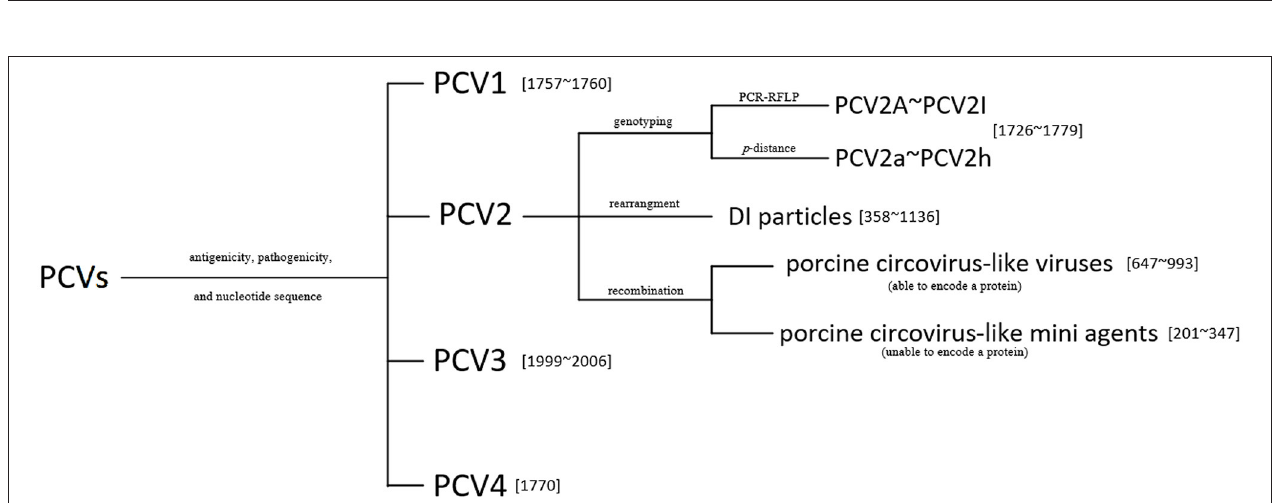
FIGURE 3 | The classification of known porcine circoviruses (PCVs). The genotyping of PCV2 (A–I) using the PCR-RFLP proposed in Wen et al. (32), and the p- distance method for the PCV2 subtypes (a–h) proposed in Franzo and Segalés (33). Numbers in square brackets indicate the genome lengths of the viruses or the mini